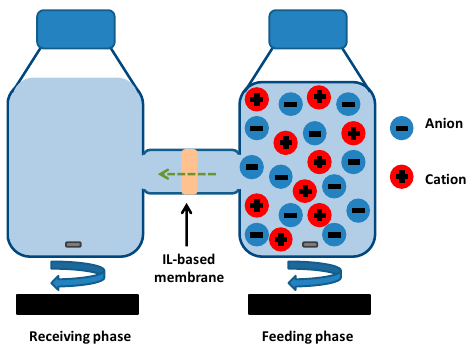
Figure 1. Scheme of the glass diffusion cell set-up used for the nutrient analysis through ionic liquid (IL)-based membranes.